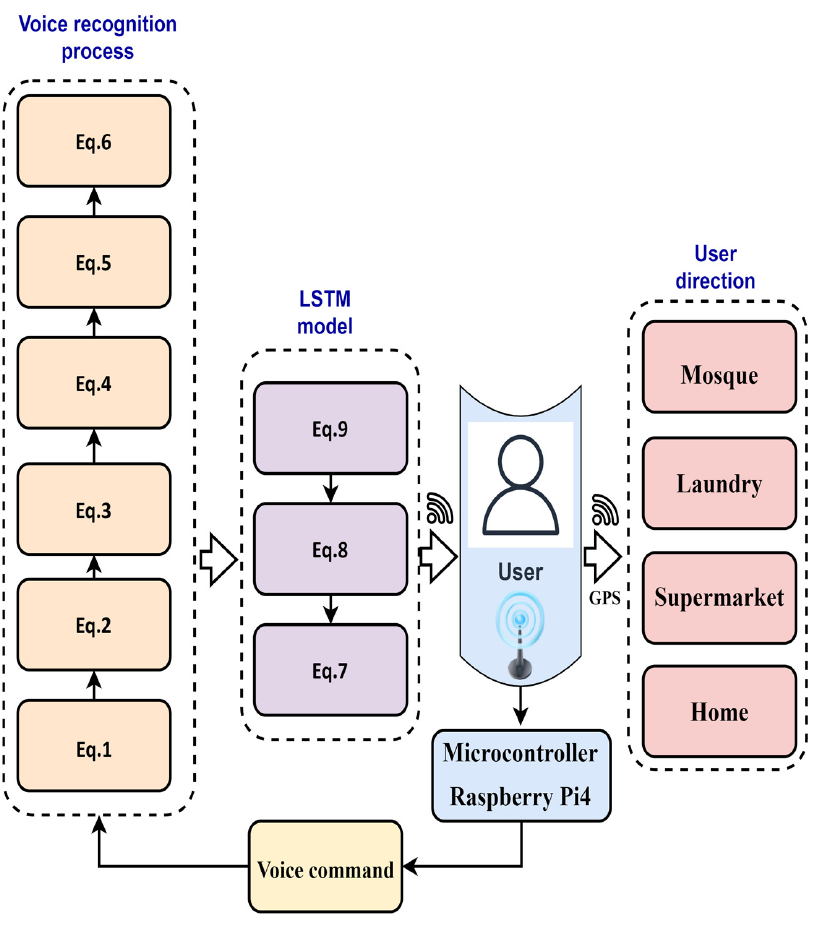
Figure 5. Flowchart of the system.